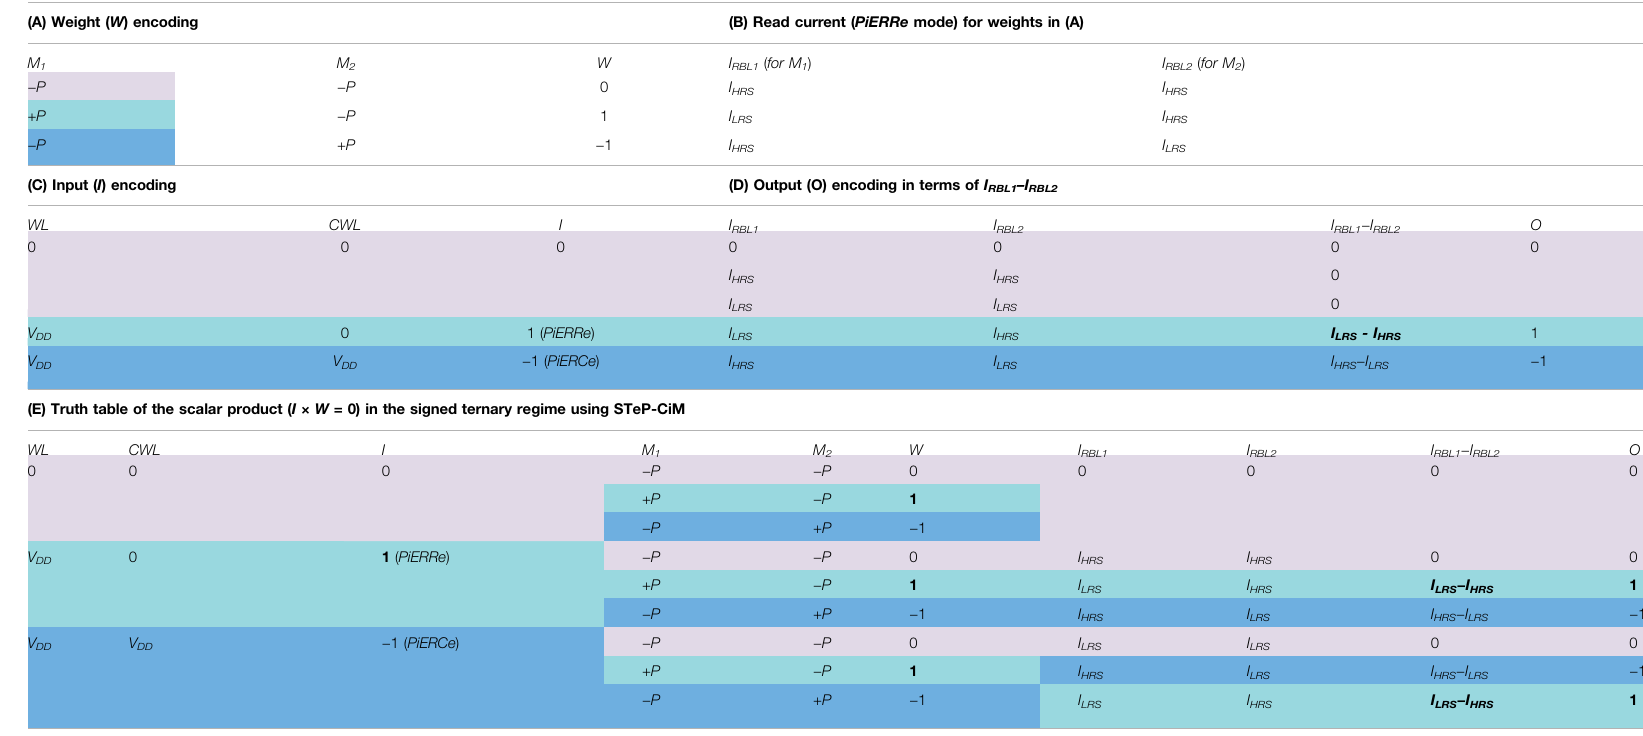
TABLE3| Signedternaryschemeof{ − 1,0,1}in(A)weights( W )representedintermsofpolarizationstoredinPeFETs M 1 and M 2 .(B)Sensedstatesofweights.(C)Inputs( I )encodedutilizingbiasesinwordline( WL )andread word line( CWL ). Itshould be noted that the inputs place PeFETs M 1 and M 2 intodifferent resistance regimes, PiERCe and PiERRe . (D) Outputs ( O ) used for MAC computation in STeP-CiM. Subtracted currents on read bit lines RBL 1 and RBL 2 signify ternary outputs. (E) Truth table of the scalar product in the signed ternary regime using STeP-CiM. (A) Weight ( W ) encoding